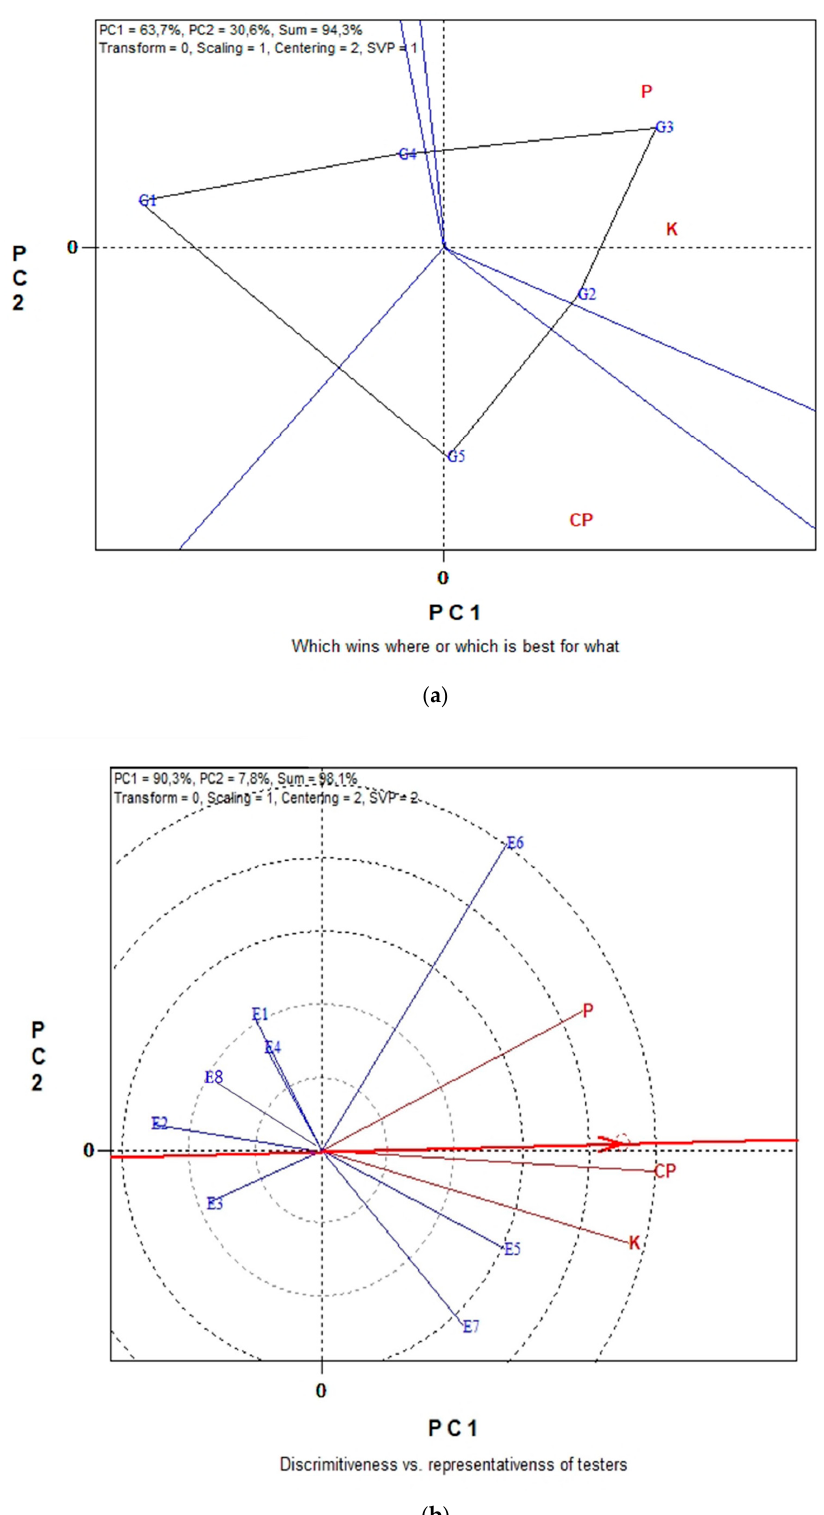
Figure 4. Biplot analysis of seed P, K macronutrient content and seed crude protein (CP) concen- tration in conventional farming: ( a ) “which-won-where or which is best for what” view of the GGE biplot based on seed macronutrient P, K contents of five lentil genotypes in eight environ- ments; ( b ) “discriminating power vs. representativeness” view of the GGE biplot based on seed macronutrient P, K contents of five lentil genotypes in eight